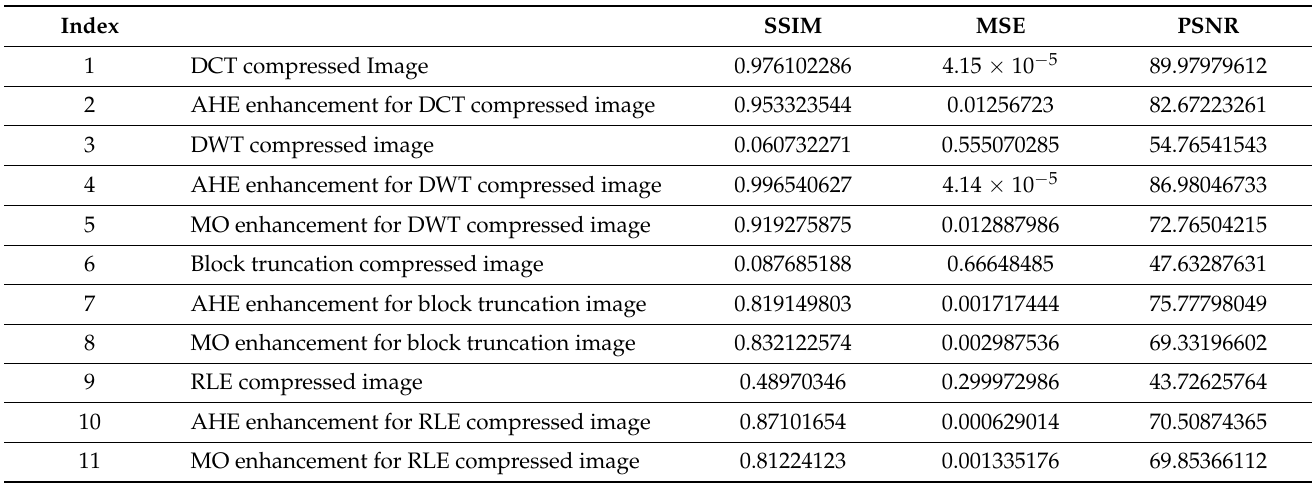
Table 1. Performance metric for the sample medical image.